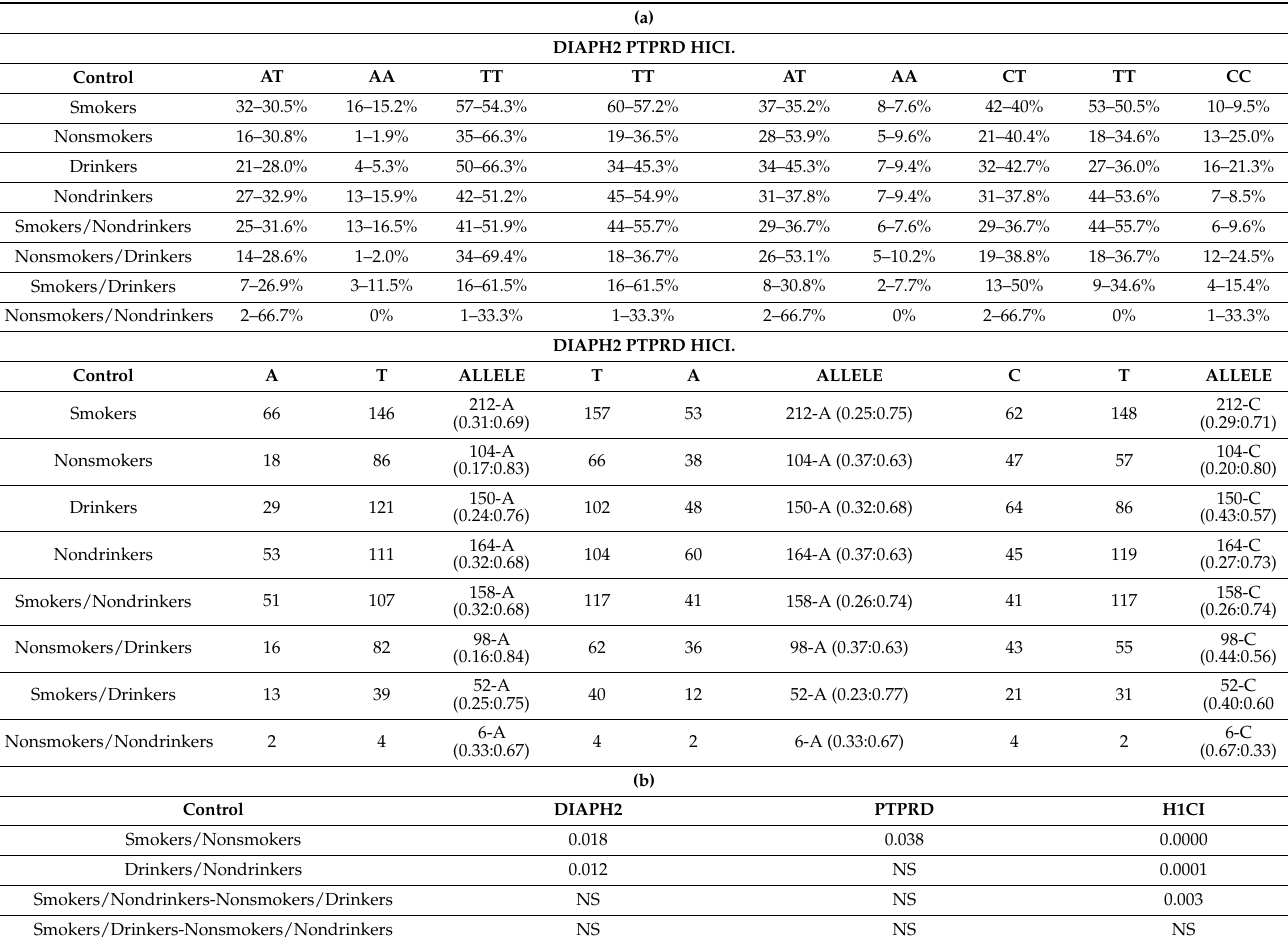
Table 5. Genotypes and alleles distribution in the control group. Comparison of alleles distribution in the control